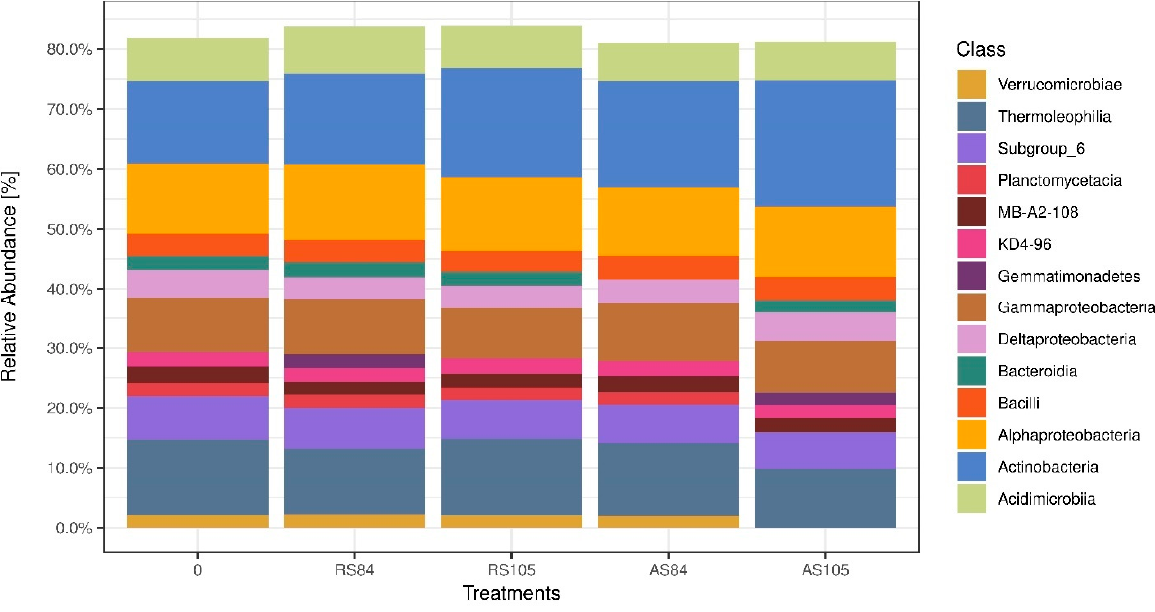
Figure 3. Bacterial abundances at the class level. 0—control treatment, no fertilization applied; AS84—84 N kg ⋅ ha –1 ,